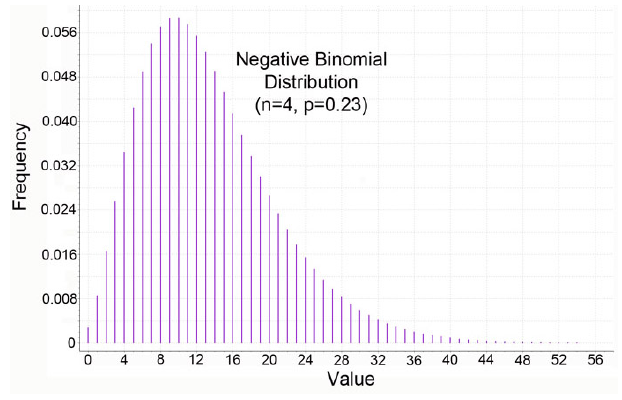
Fig. 3 . The negative binomial distribution used to estimate kills per building per year in our Monte-Carlo analysis for low-rise commercial and institutional buildings that we categorized as ‘Most Likely’ to cause mortality in